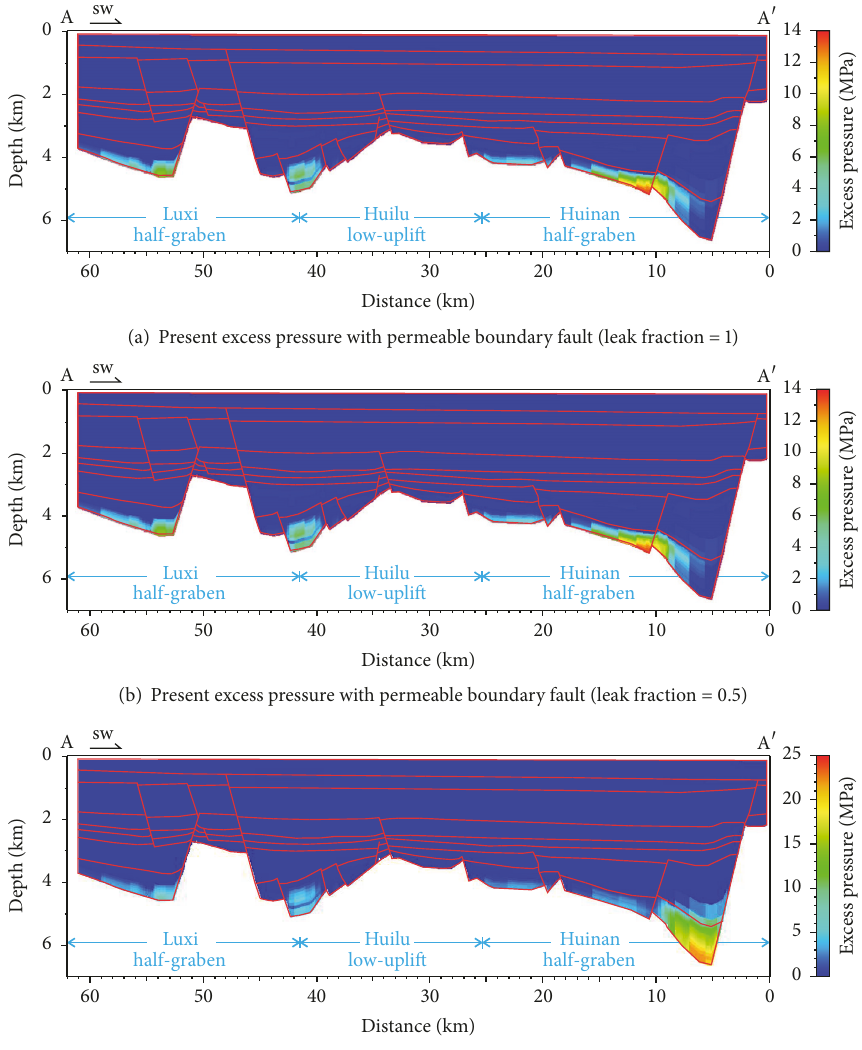
Figure 25: Sensitivity analysis of permeability of fault zones in the Huizhou Sag (the location of profile AA 󸀠 is shown in Figure 1).